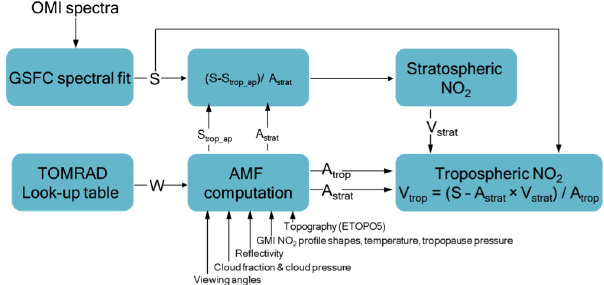
Figure 1. Schematic description of the OMI NO 2 processing al- gorithm. S variables represent slant column densities (SCDs); A represents air mass factors (AMFs). V variables represent vertical column densities (VCDs). W denotes the scattering weight (Eq. 1), pre-computed using the radiative transfer program